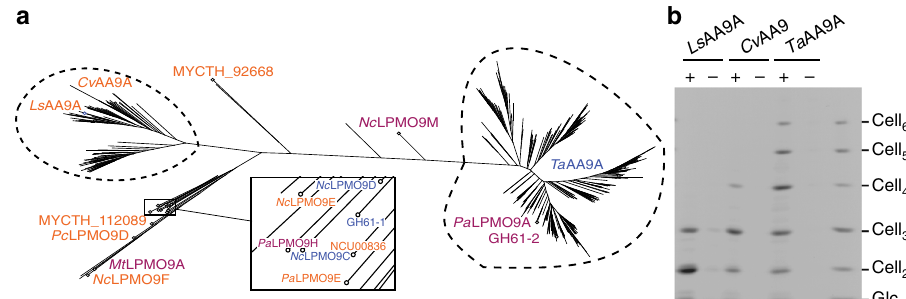
Fig. 1 Sequence similarity between Ls AA9A, Cv AA9A and Ta AA9A, and analysis of their reaction products. a Distance tree of 444 selected AA9 sequences (see Methods). Blue, purple and orange labels designate AA9 enzymes that oxidize the sugar ring at C1, C4 and C1+C4, respectively. See Supplementary Table 1 for protein accession numbers. Unlabelled branches represent AA9 enzymes for which the regioselectivity of oxidation is not available from the literature. b PACE gel showing reaction products of the three enzymes on PASC; +, incubation with 4 mM ascorbate; − , incubation without ascorbate (performed in